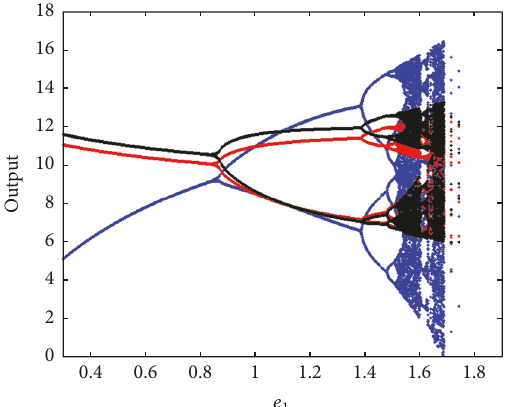
Figure 16: Bifurcation diagram with 𝑒 1 , 𝛼 = 0.2 , 𝛽 = 0.2 , and 𝛾 = 0.2 .